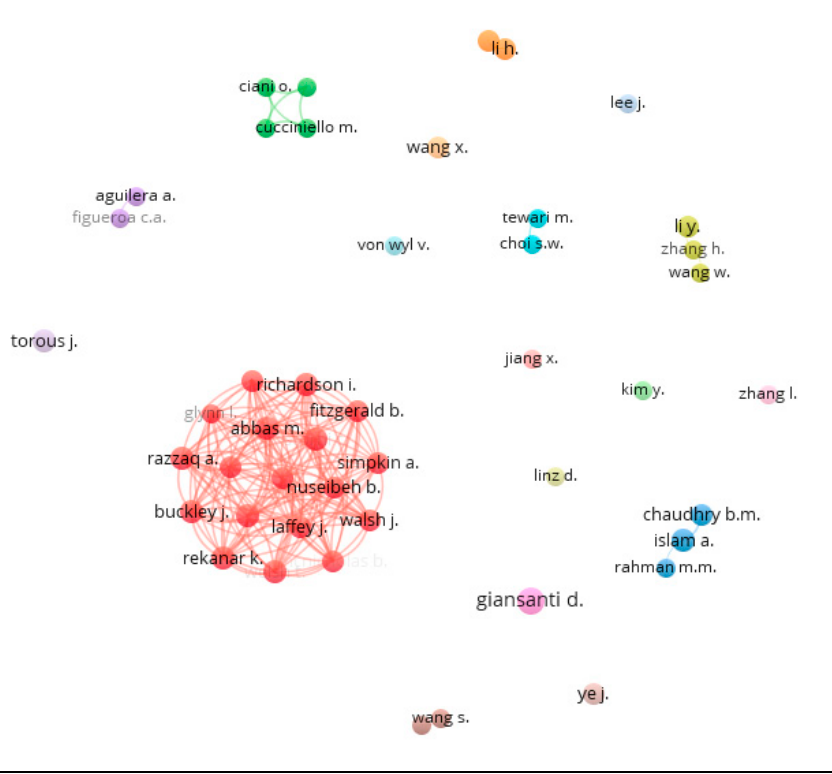
Figure 2. Co-authorship analysis at the author level. (Note: 18 clusters were identified with the largest one (red in color) with 18 researchers; see the text for more details)